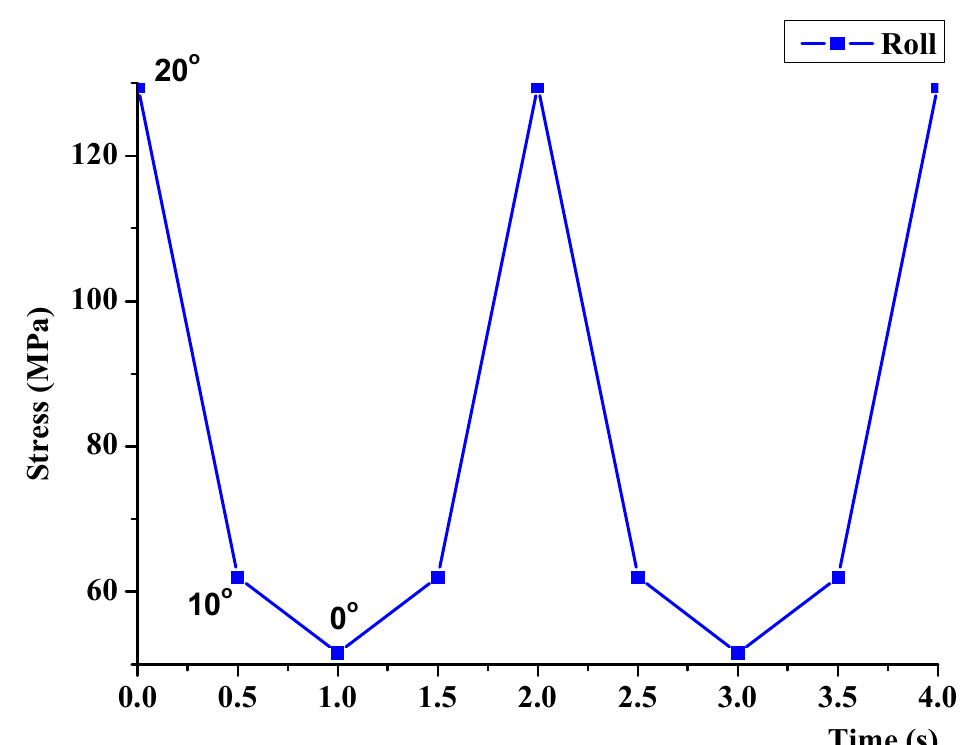
Figure 13. The maximum stress of the roll motion.